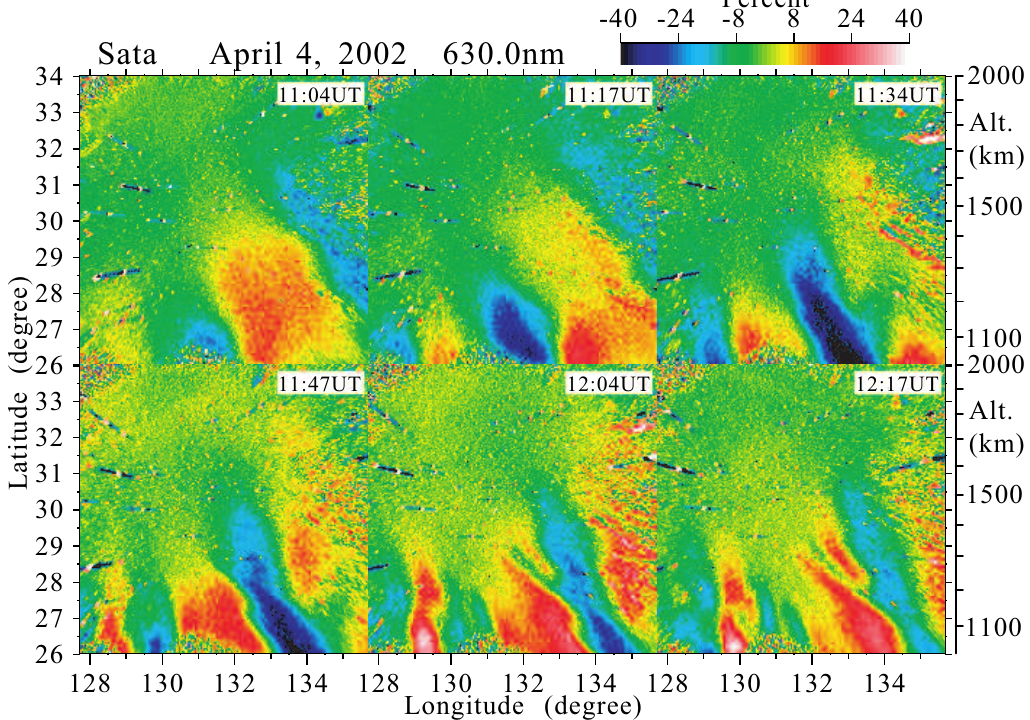
Fig. 3. Evolution of the plasma bubble structure seen in the 630.0-nm airglow images at Sata, Japan, at 11:04–12:17 UT (20:04–21:17 LT) on 4 April 2002. The raw all-sky images were converted into geographic coordinates by assuming an airglow height of 250km. The images are deviations in unit of % from 1-hour running averages. The apex height of the magnetic field line at the equator is shown in the right of the panels. The bubble structure can be identified in blue (depletion of airglow intensity) extending from lower to higher